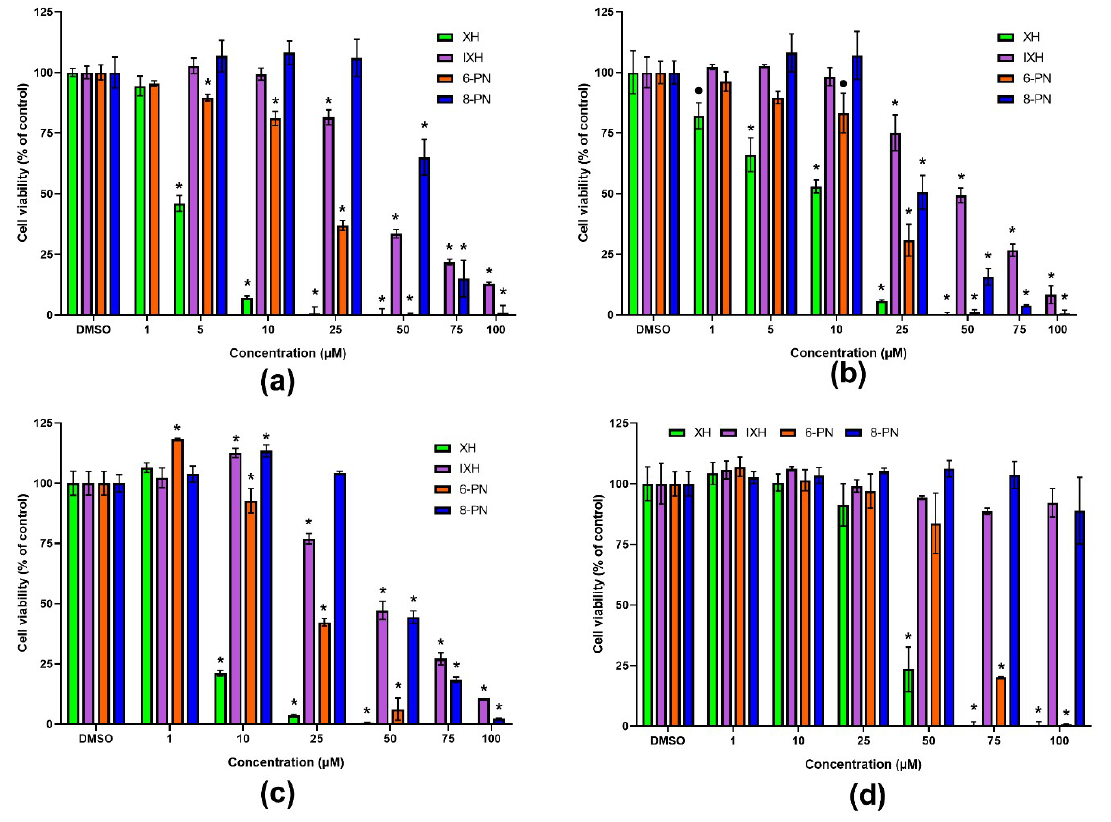
Figure 2. E ff ect of prenylflavonoids on the viability of SW480 ( a ), SW620 ( b ), proliferating CaCo-2 ( c ), and di ff erentiated CaCo-2 cells ( d ) after 72 h of treatment. The cell viability was assayed using the neutral red uptake assay. Data are presented as a percentage of the respective control ( = 100%) and represent the mean ± S.D. ( n = 3) ( • data with p < 0.01, * p < 0.001, one-way ANOVA with Dunett’s test). Table 1. IC 50 values [ µ M] of NAR and prenylflavonoids (XH, IXH, 6-PN, 8-PN) in SW480, SW620 and CaCo-2 cells after 72 h of exposition.